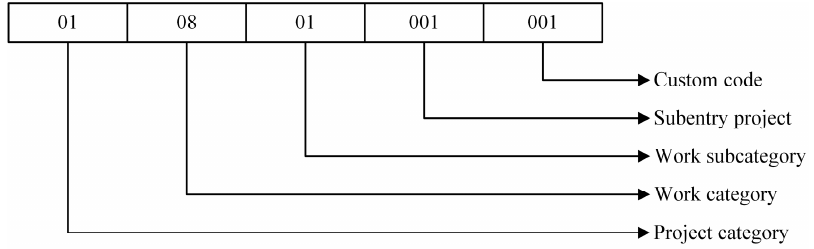
Figure 3. Example of the classification and coding system of GB 50500.